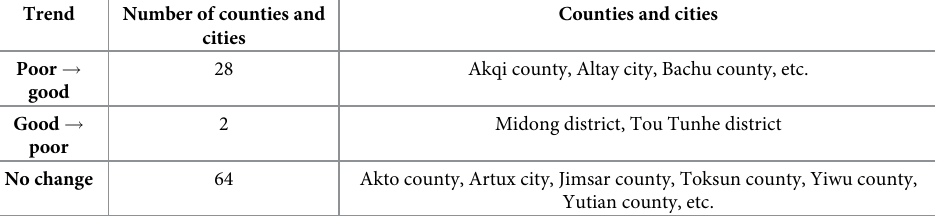
Table 4. Comparison of the number of counties and cities by C EDI and C EDI ’.